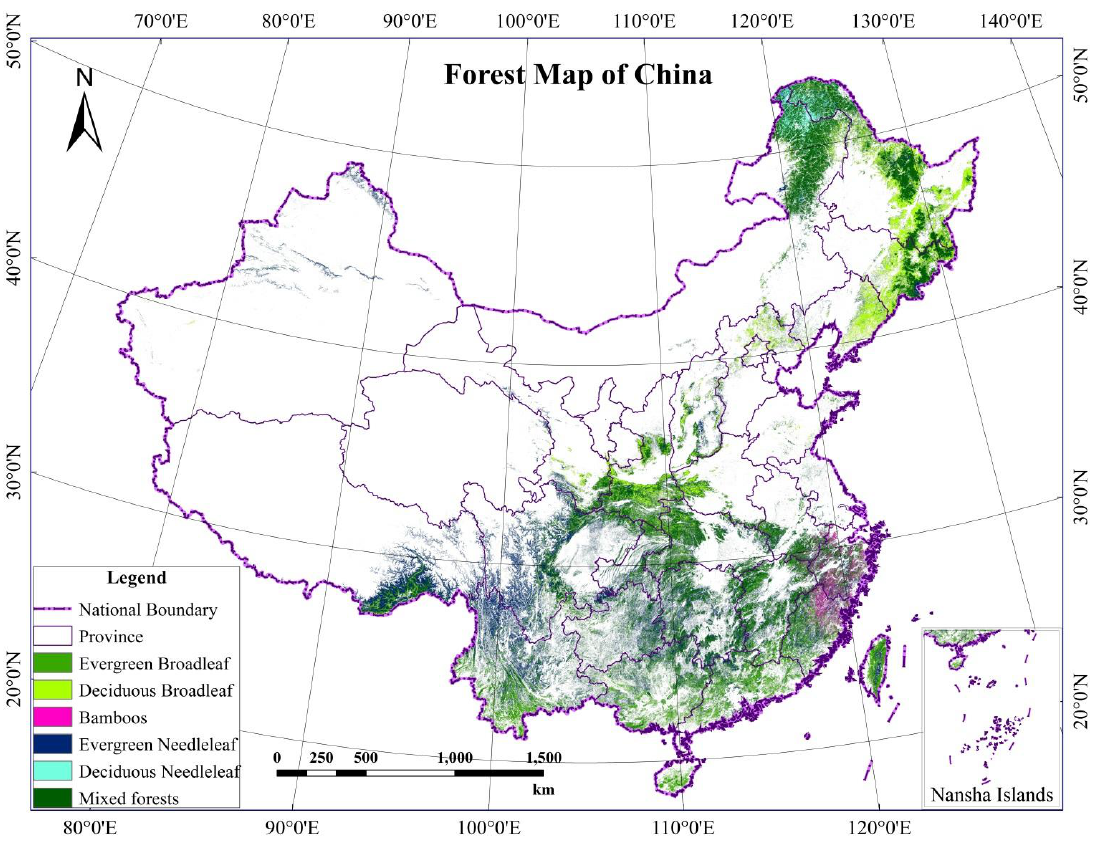
Figure 3. The forest map of